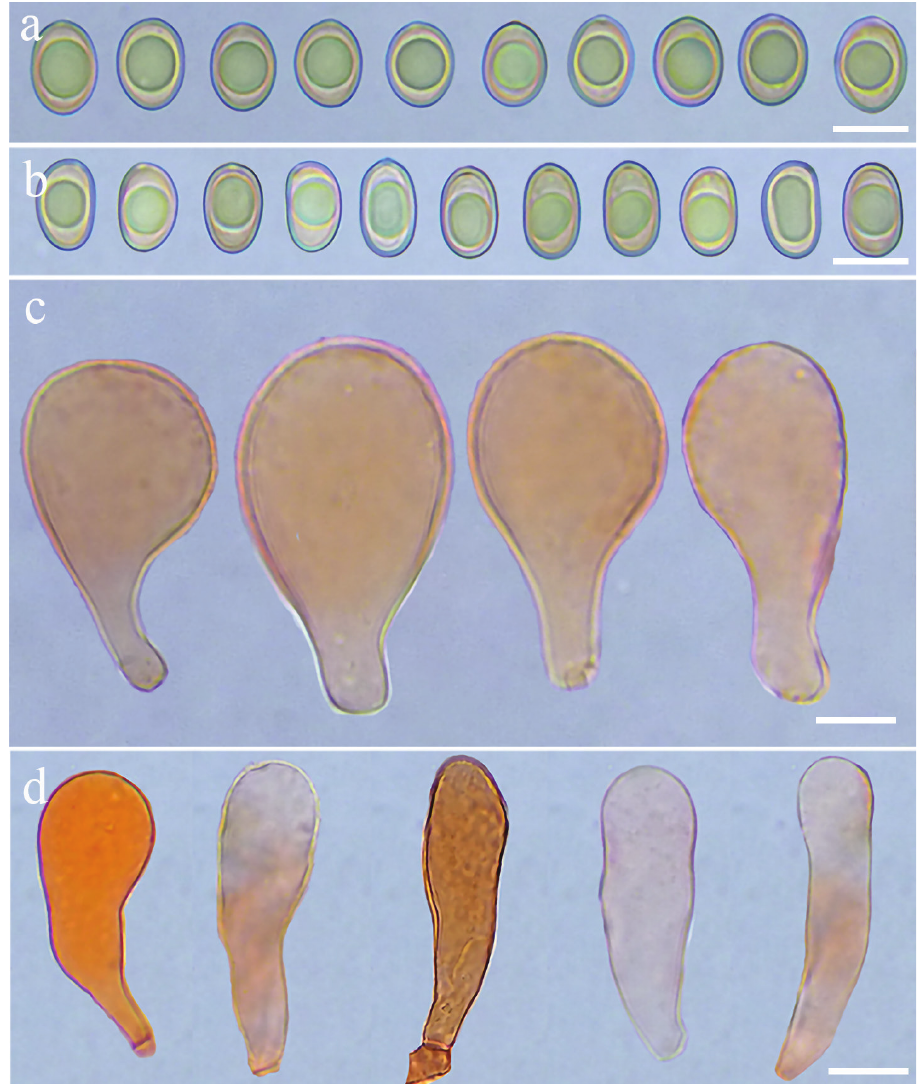
Figure 6. The comparisons of the two new species in their outline of basidiospores and cheilocystidia shape a, c basidiospores and cheilocystidia of I. hainanense (FHMU3162, holotype); b, d Basidiospores and cheilo- cystidia of I. muscarium (FHMU3166, holotype). Scale bars: 10 μm ( a–d ). Photos by L.-S.